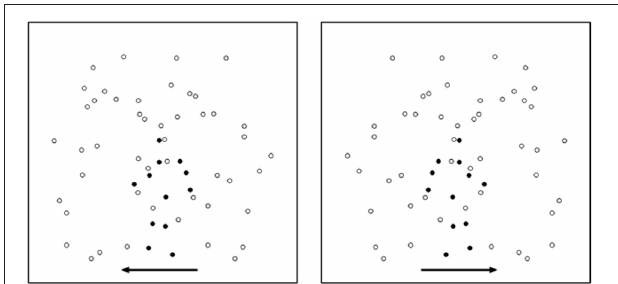
FIGURE 1 | An illustration of stimuli used in Task 1 (perceptual discrimination of BM). Here, for the purpose of illustration, signals dots are signified in a more salient color (dark). Noise dots are signified in a less salient color. The arrows indicate two possible walking directions (left and right). In an actual display, the two types of dot were in the same color and the arrows were not